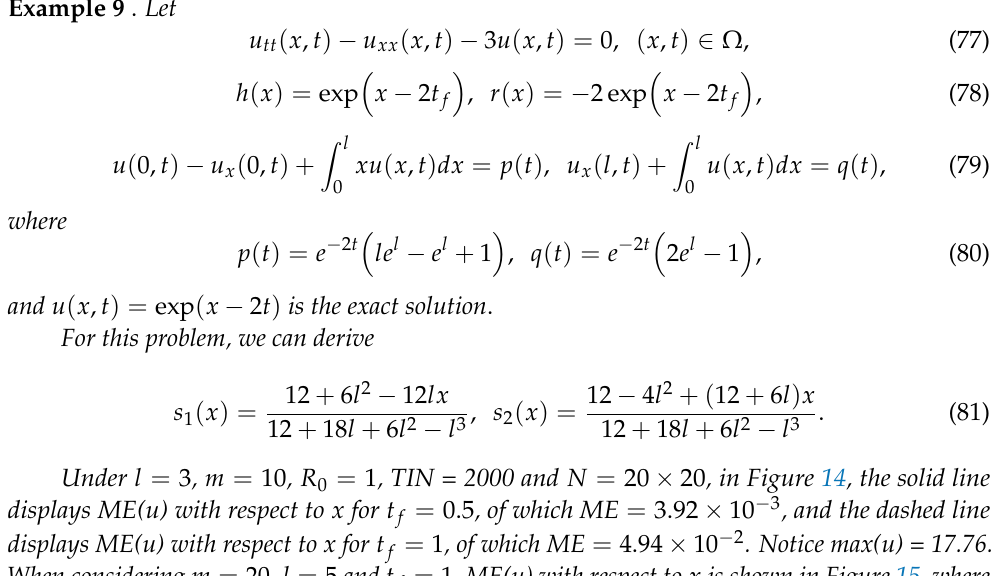
Figure 13. For Example 8 of the backward nonlocal wave problem of the Klein–Gordon equation under two-side nonlocal BCs: ME( u ) versus x with different final times.